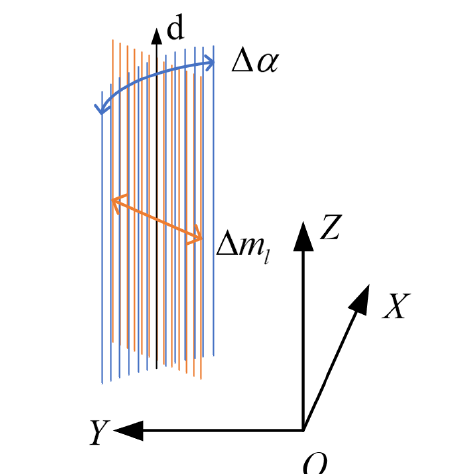
Figure 4. The variation of line position(with fixed direction d ) with the fluctuation of m l and α . The fluctuation ∆ m l is added to m l and ∆ α is added to α